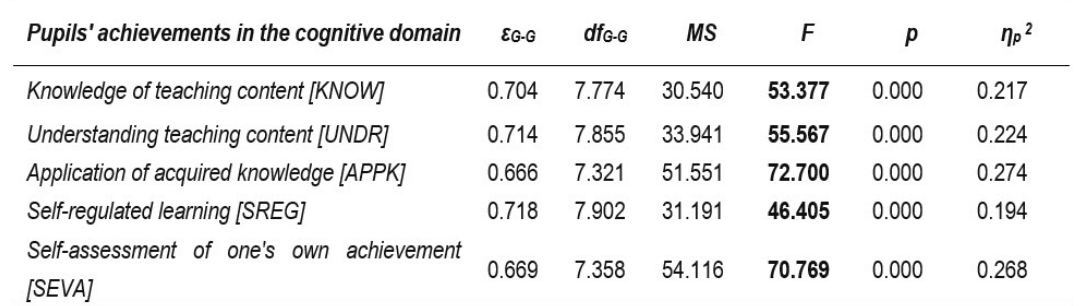
Results of repeated measures ANOVA of the teachers’ perceptions on pupils’ achievements in cognitive domain: coefficient of correction of degrees of freedom (εG G), degrees of freedom with GG